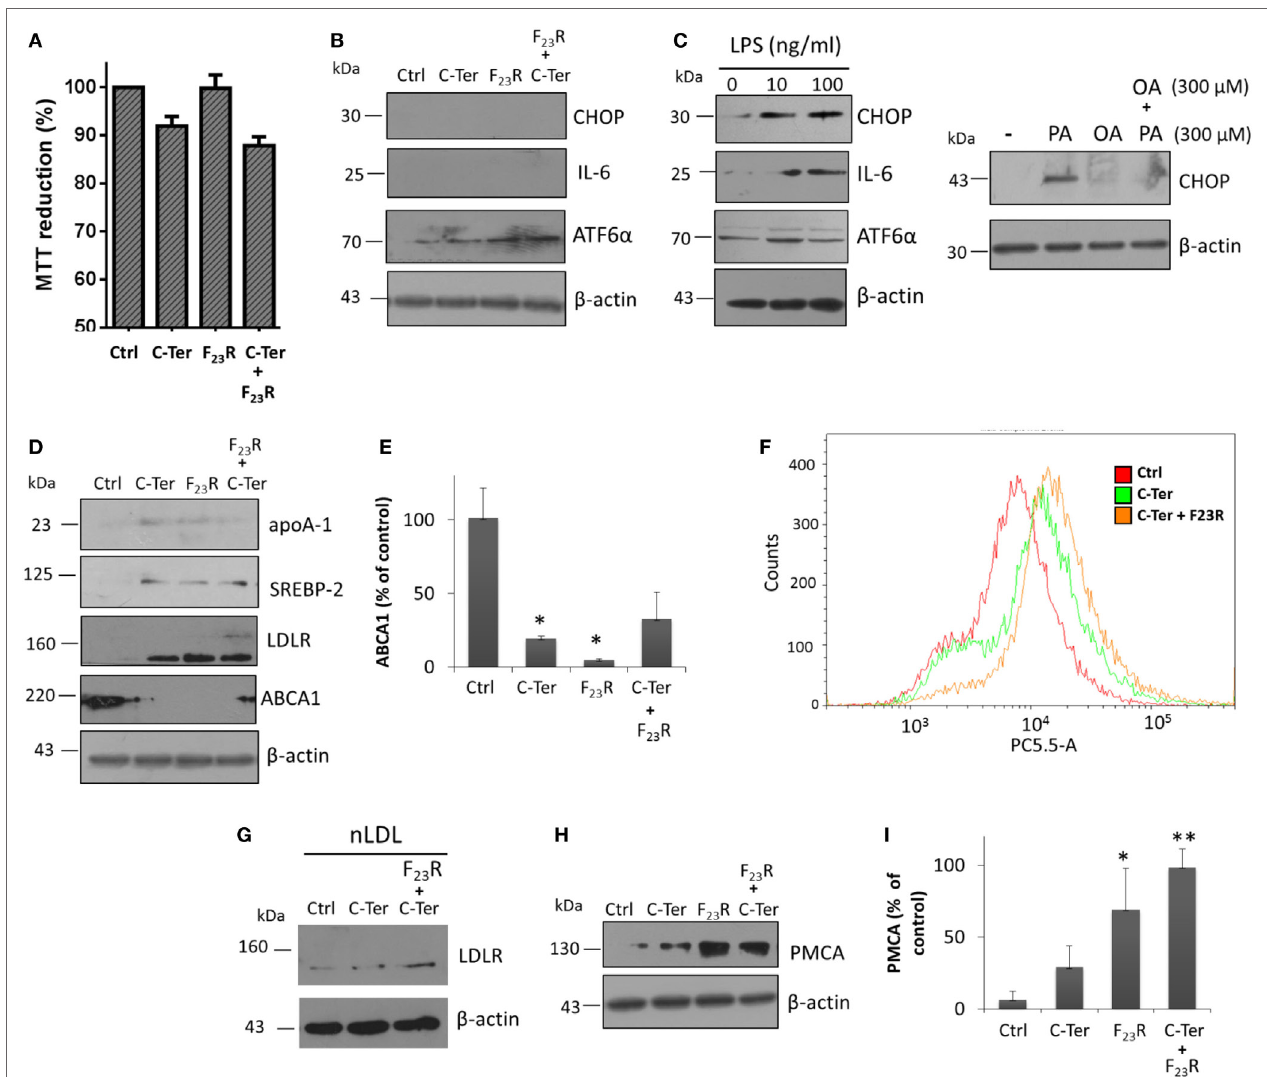
FigUre 8 | Islet amyloid polypeptide (IAPP) sequences modulate cholesterol metabolism in hepatocytes. (a) Cells were treated with equimolar concentrations of peptide variants (7.5 µg/mL), and MTT assay was performed, (B) as well as CHOP, IL-6 and ATF6 α expression were evaluated. (c) LPS incubation was used as a positive control of CHOP and IL-6 activation. In addition, fatty acids PA and oleic acid were employed as a regulator condition of CHOP expression. (D) Proteins targets that regulate cholesterol metabolism were characterized, under IAPP peptide incubation. (e) Quantification of ABCA1 expression compared to β -actin control. (F) Cytometer analysis on internalization of dil-LDL (3 µg/mL). (g) Expression of LDLR under hepatocyte stimulation with native dil-LDL. (h) Western-blot of PMCA, and (i) quantification of PMCA expression compared to β -actin control. For western-blot analysis, * p < 0.05, ** p < 0.01 compared to